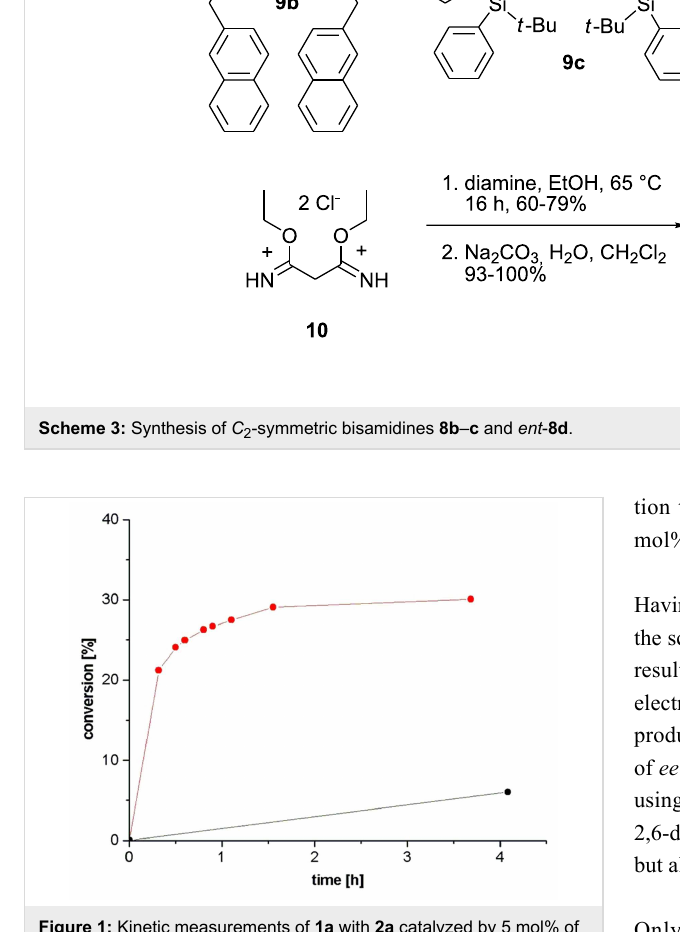
Figure 1: Kinetic measurements of 1a with 2a catalyzed by 5 mol% of 8a ·H + ·TFPB - (black line) and 1 mol% 8a (free base; red line).